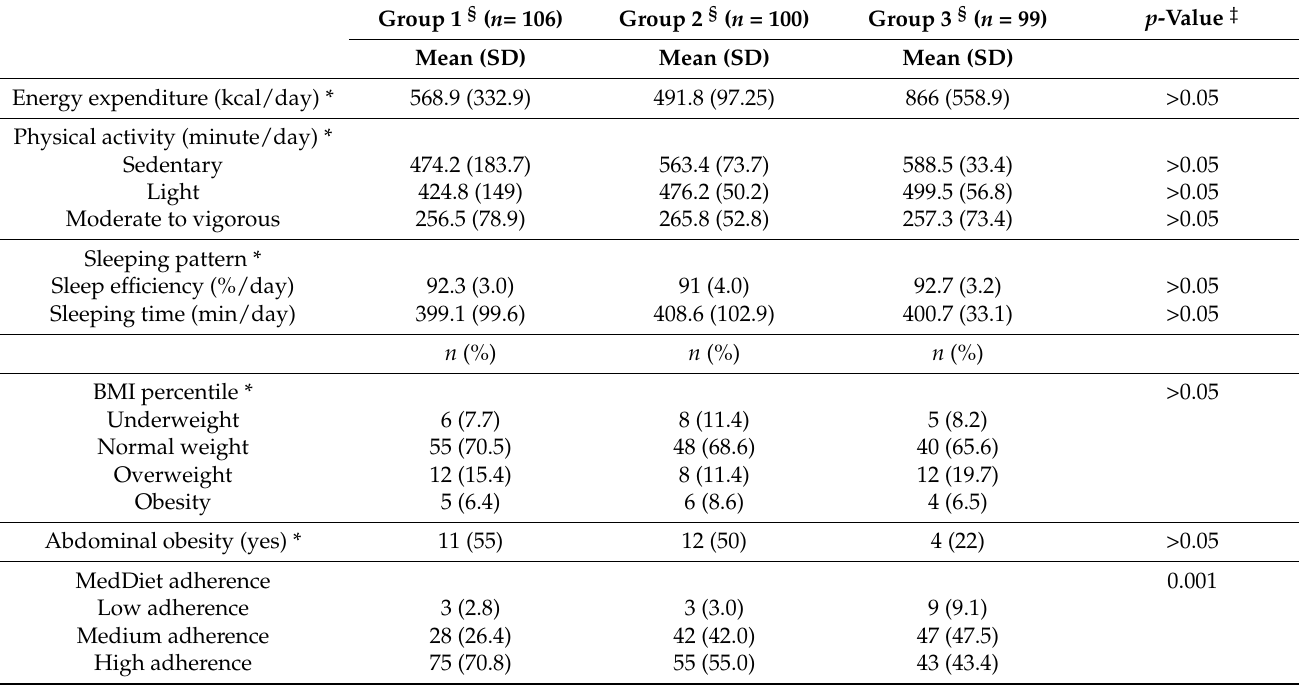
Table 3. Health parameters and health-related behaviors in children according to health-related quality of life.